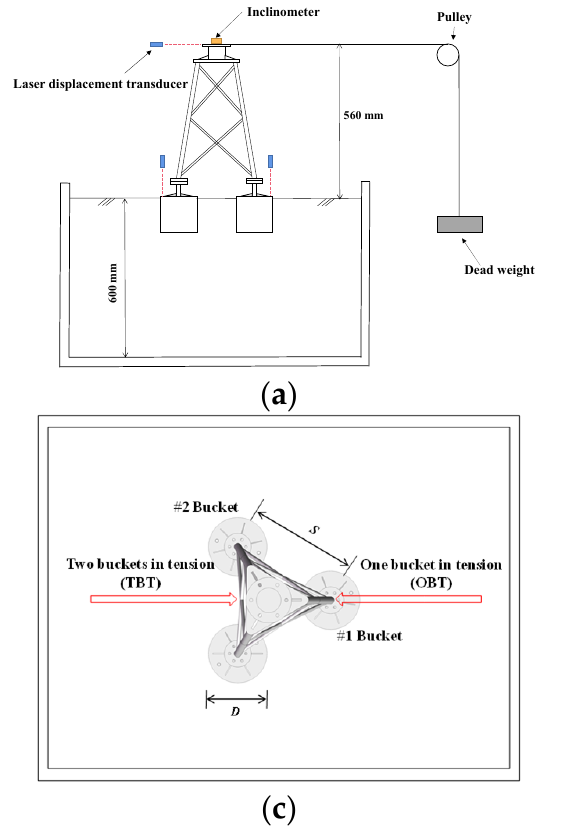
Figure 4. Setup of model test: ( a ) sketch map, ( b ) photo of the experimental setup, ( c ) plane view of loading directions.